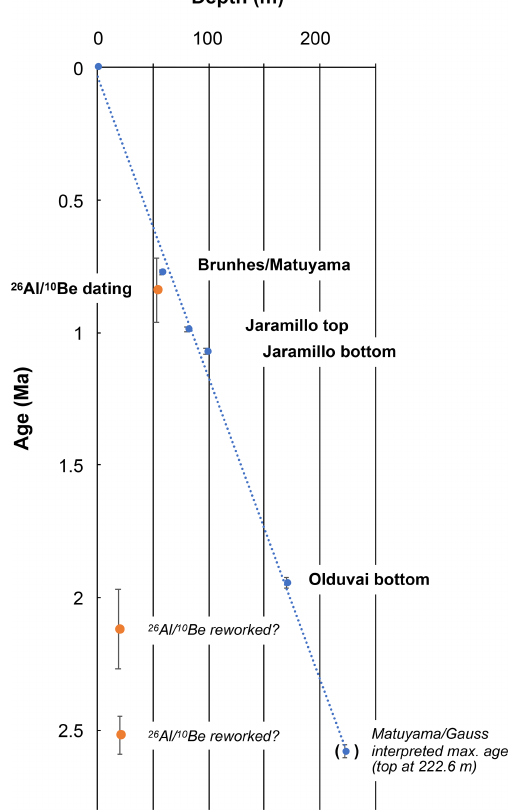
Figure 4. Age–depth relation in core GN200. The age model is re- lated to the interpreted magnetostratigraphy. Radionuclide datings are given in addition. For more discussion see the text.